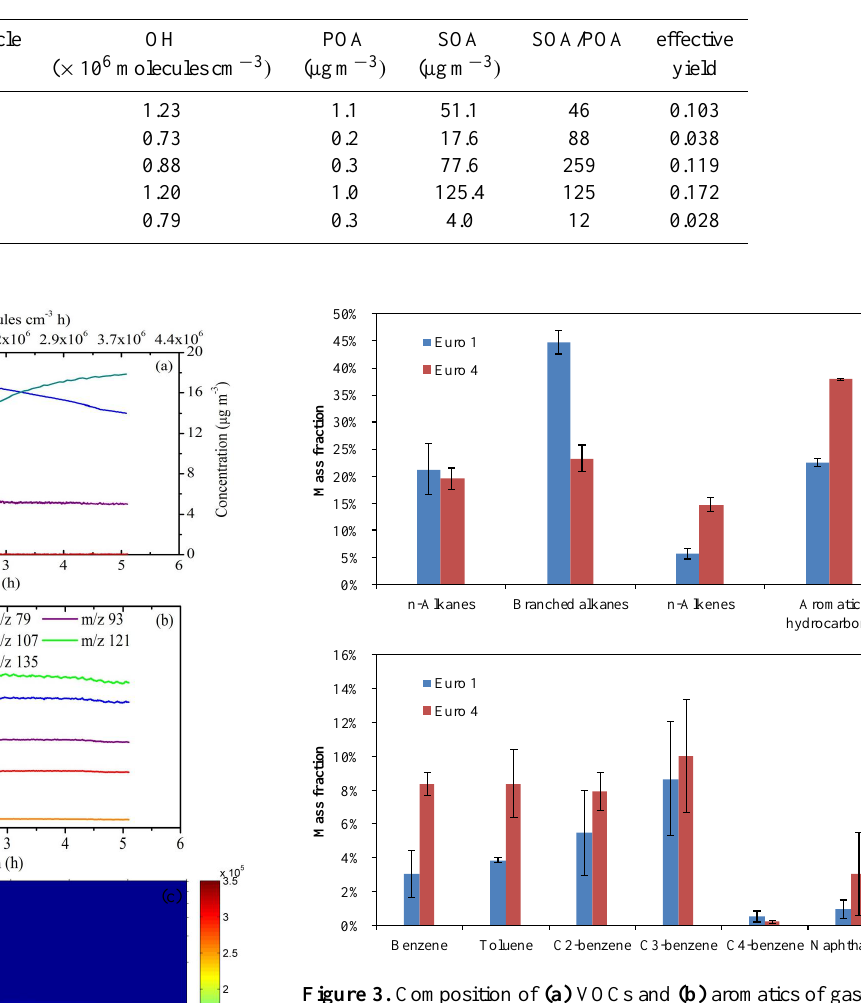
Figure 3. Composition of (a) VOCs and (b) aromatics of gasoline vehicle exhausts from Euro 1 and Euro 4 private cars, presented as weight percentage of speciated VOCs. C2 and C3 and C4–C12 hy- drocarbons were measured by GC-FID and GC-MSD, respectively. The error bars (1 σ ) represent variability from measurements for each